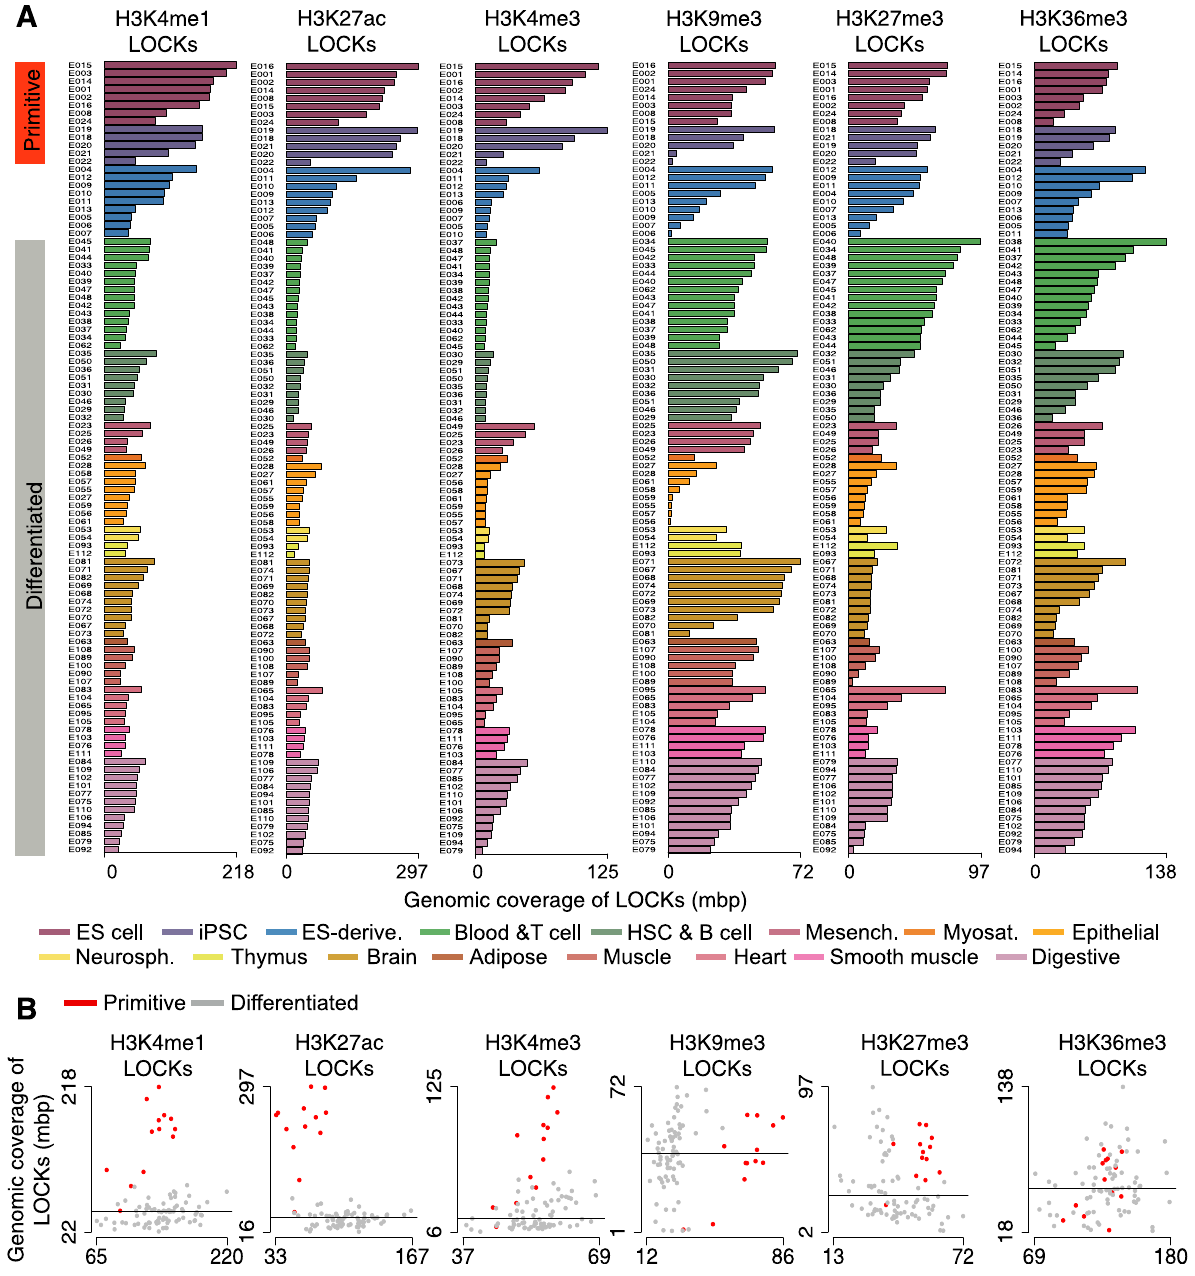
Fig. 1 Genomic coverage of LOCKs discriminates primitive from differentiated cell types. A Genomic coverage of LOCKs identi fi ed using H3K4me1, H3K4me3, H3K27ac, H3K9me3, H3K27me3 and H3K36me3 histone modi fi cation pro fi les across 13 primitive, 9 ES-derived and 77 differentiated cell types. B Comparison of genomic coverage by LOCKs and individual regions (Ind. elements) post-translationally modi fi ed with histone marks in 9 primitive and 77 differentiated cell types (ES-derived excluded). Each dot corresponds to one cell type